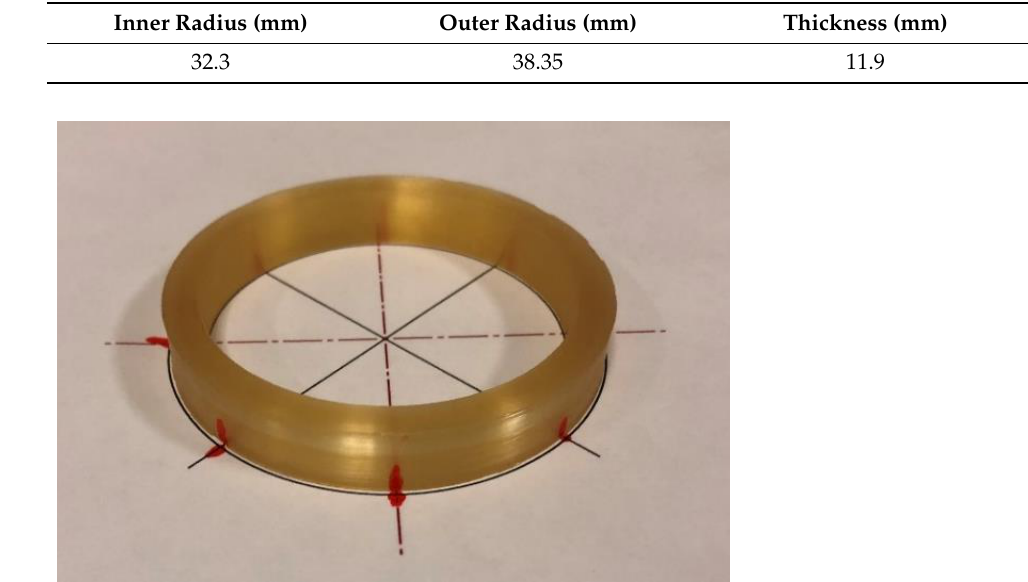
Table 2. Dimensions for Type-1 quadrupole wound coils (Figure 1).